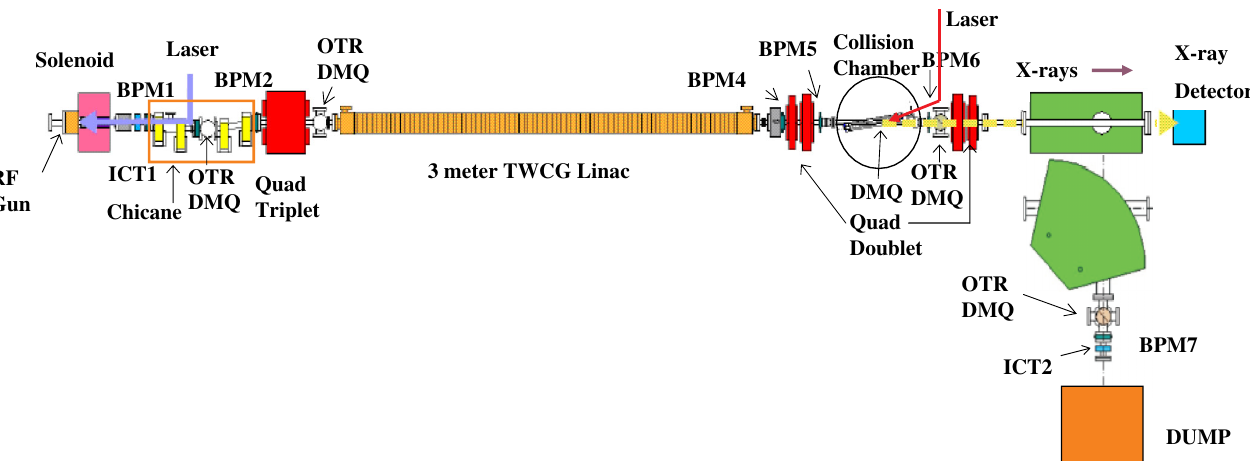
FIG. 1. Setup of the LUCX test facility. The rf gun is installed at the left end and the dump is positioned at the bottom right. The collision chamber is the interaction region where the electron beam collides with the laser pulse to produce x rays via inverse Compton scattering. Two independent laser systems are used, one to produce electron bunches in the rf gun and one to produce laser pulses to collide with the